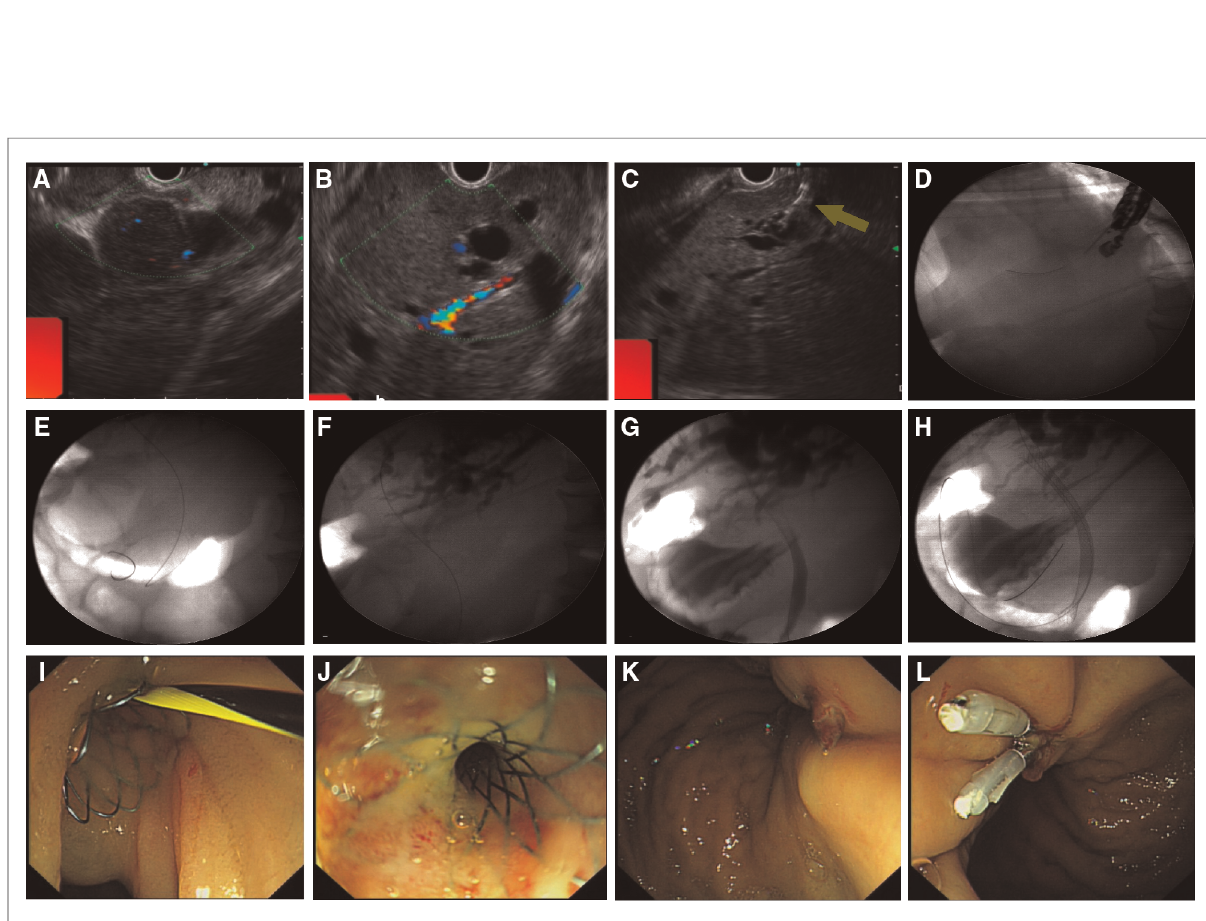
FIGURE 2 Endoscopic ultrasonography – guided biliary drainage. ( A ) Linear-array ultrasonography showed numerous fi lling lymphomatous nodules in the abdominal cavity. ( B,C ) The left hepatic duct was located for puncture. ( D,E ) The guidewire was passed through the con fl uence of the left and right hepatic ducts, and then through the site of common bile duct stricture. ( F,G ) Radiography indicated that the stricture site at the upper common bile duct was 4 cm away from the hepatic portal. ( H ) A bare metal stent (8 cm×10 mm) was placed transgastrically in the common bile duct in an antegrade manner. ( I,J ) Gastroscopy demonstrated that the stent was passed through and stretched exactly out of duodenal papilla. ( K,L ) The puncture point in the stomach was closed with a titanium